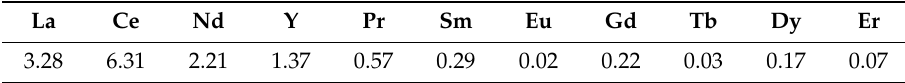
Table 2. The maximal content was for light rare elements: cerium, lanthanum and neodymium (11.8%) Table 2. Inductively coupled plasma–optical emission spectrometry (ICP-OES) analysis of REE in steenstrupine concentrate (in weights